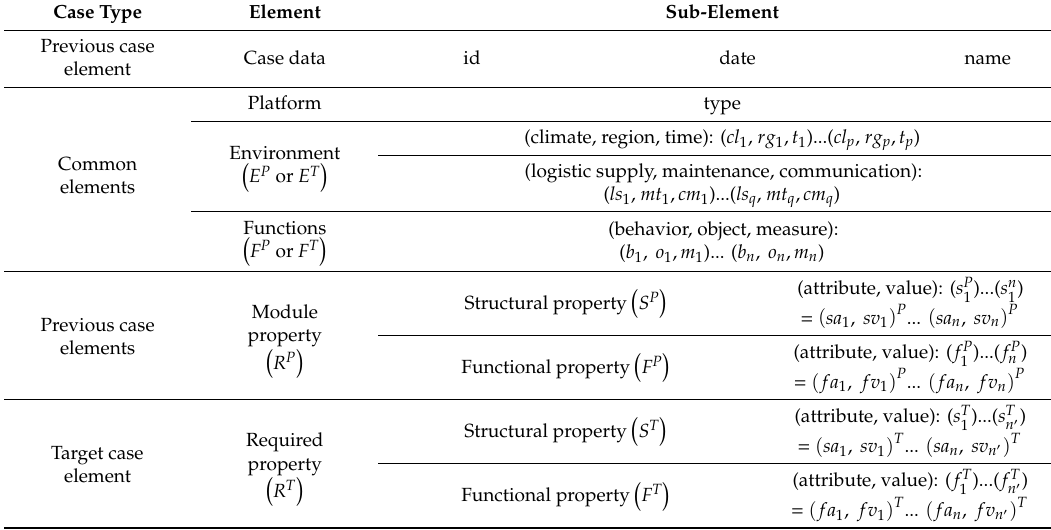
Table A2. Generalized structure for previous and target case.